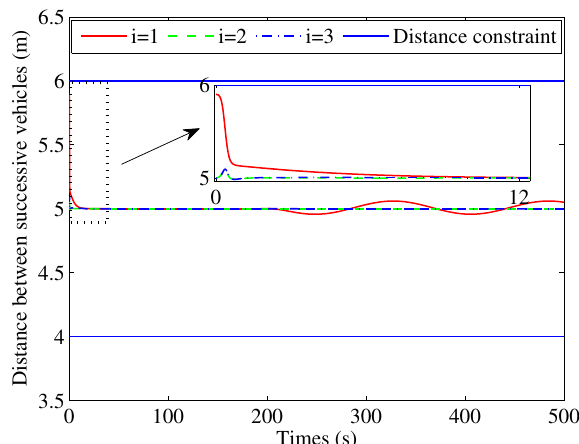
Figure 10. LOS range d i and the maximum connectivity distance and minimum collision distance under NN adaptive control.